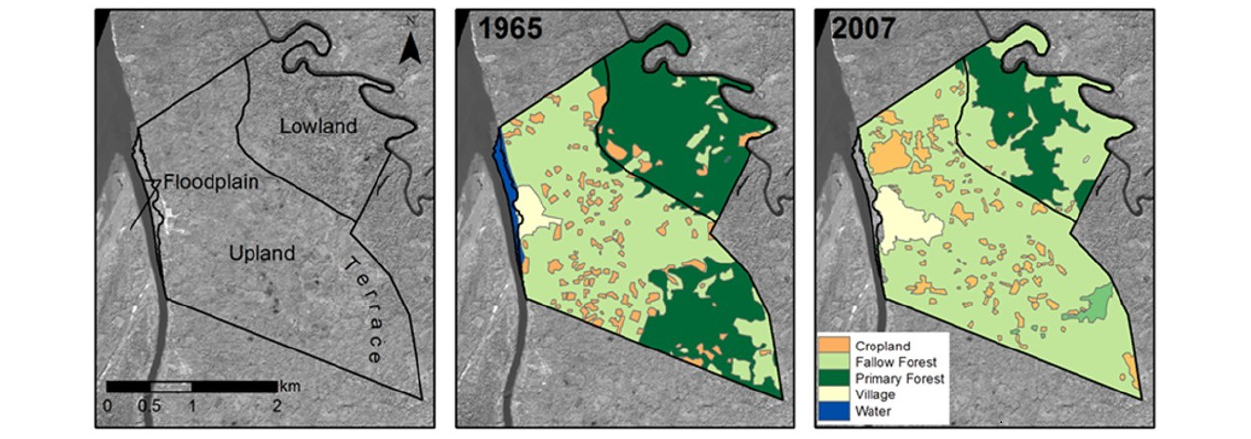
Fig. 2 . Land types and land cover, San Jose, 1965 and